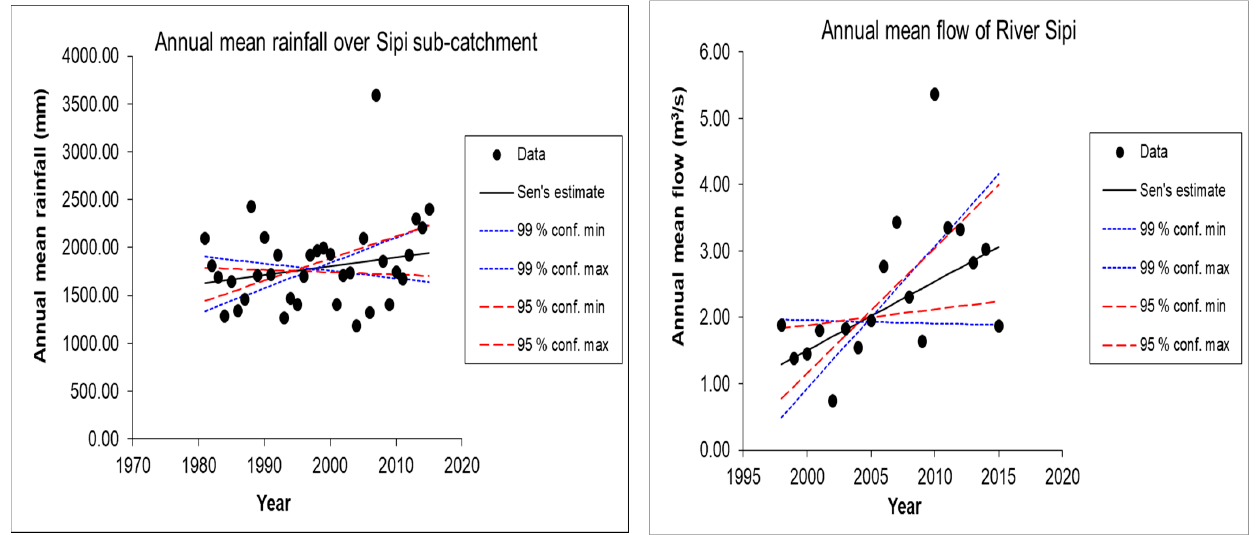
Figure 9. Tine series of annual rainfall over Sipi sub-catchment (1981–2015) and River Sipi flow (1998–2015).